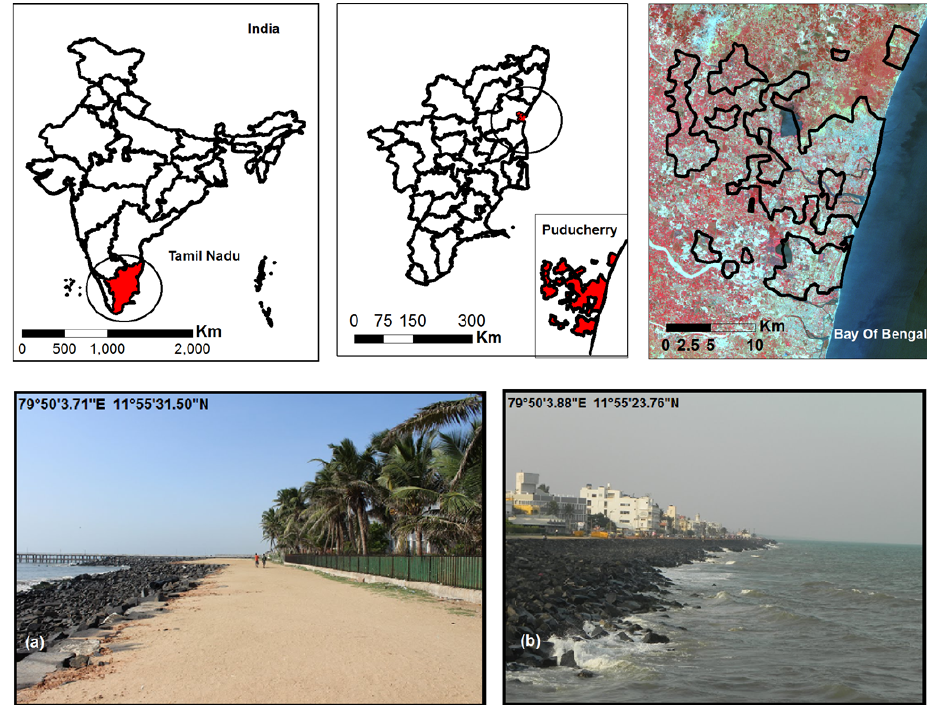
Fig. 1. Map showing location of study area. (a) This photo was taken near to the duplex park and compound wall of the park guest house complex. Rock boulders are seen to arrest the coastal erosion. This place is close to the highly populated urban area. (b) This photo shows the absence of beach, coastal road along the coastline, urban development, etc. It is just north of Puducherry harbour